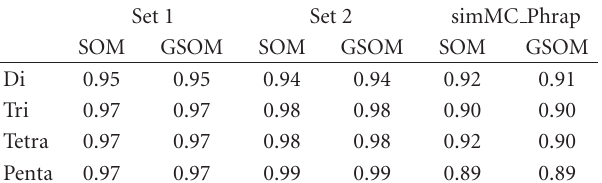
Table 2: The evaluation of clustering results using